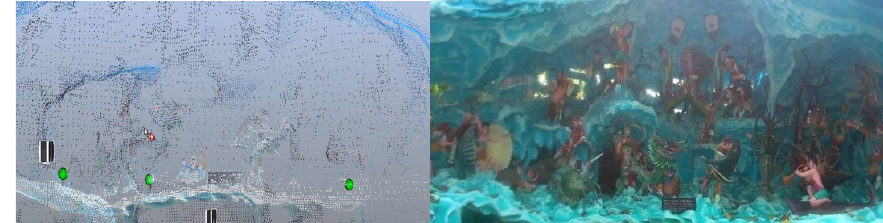
Figure 10. 3D point cloud and color picture of Eight Immortals in Haw Par Villa.